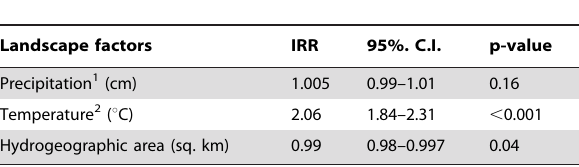
Table 2. Adjusted incidence rate ratios (IRR) for the independent associations between human WNV and the landscape